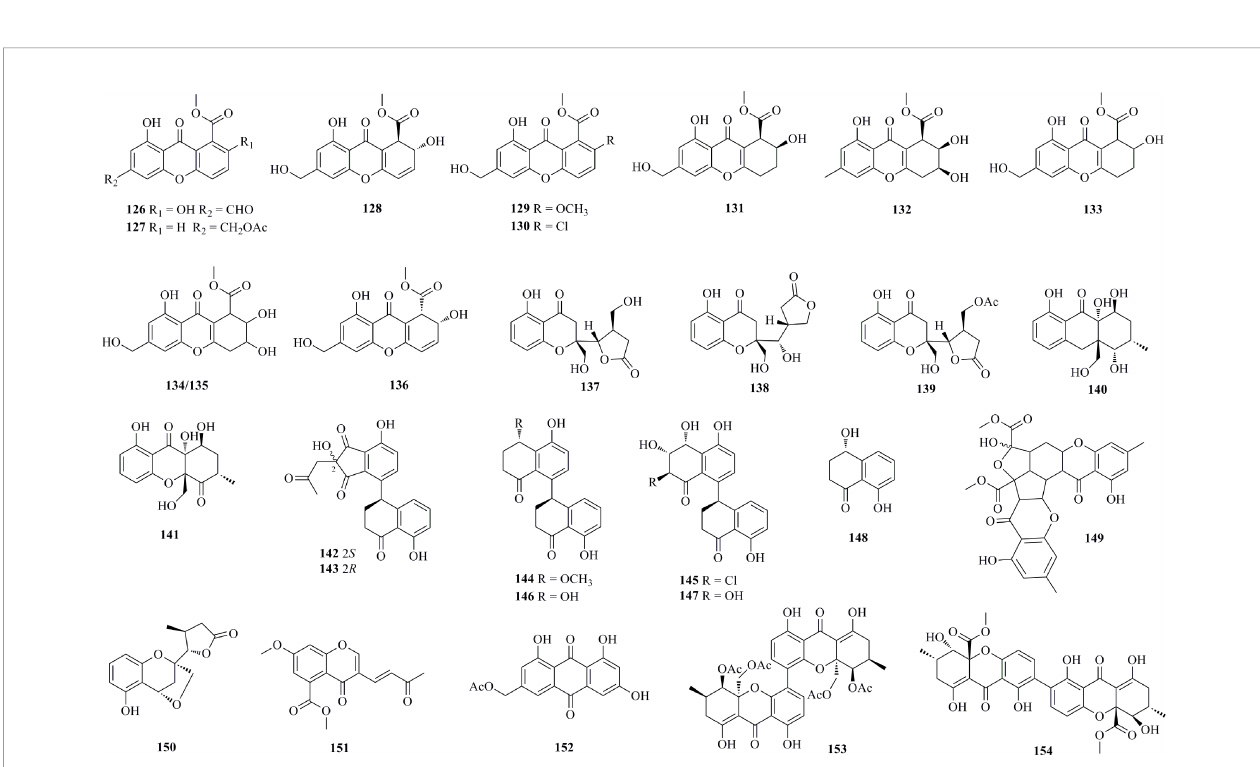
FIGURE 8 | Chromones isolated from deep-sea fungi ( 126 − 154